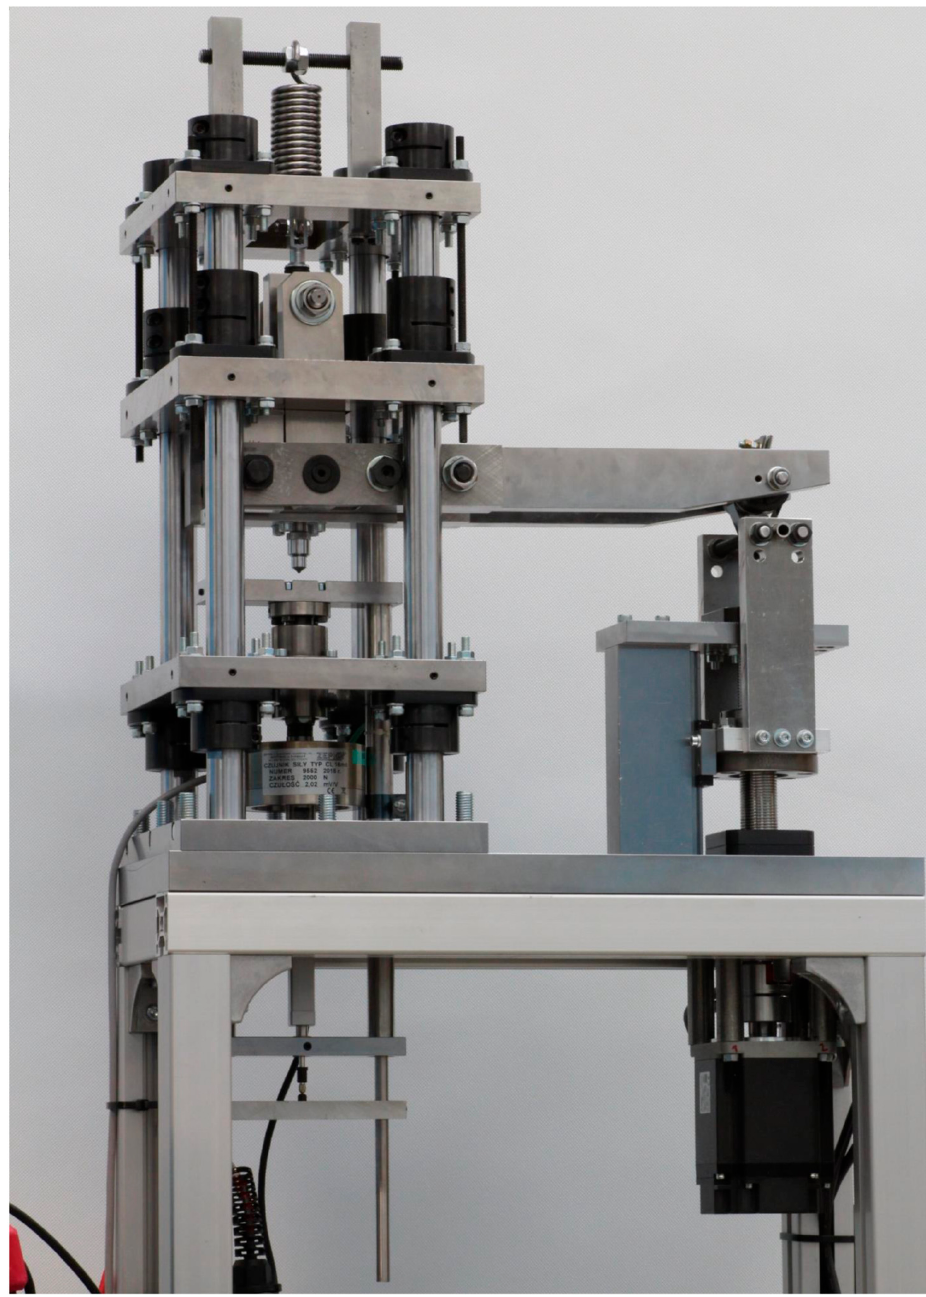
Figure 3. Device for indentation tests—instrumented hardness